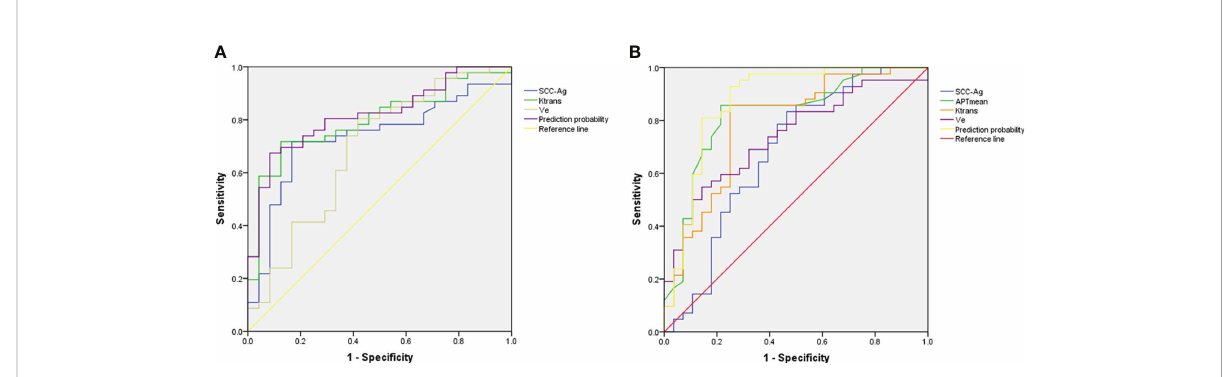
FIGURE 4 (A) ROC of K trans , V e , SCC-Ag and combined values (SCC-Ag+K trans ) for the prediction of DSI. (B) ROC of SCC-Ag, APT mean , K trans , V e and combined values (APT mean +K trans ) for the prediction of LVSI. The combined values for DSI and LVSI both show the highest AUC.